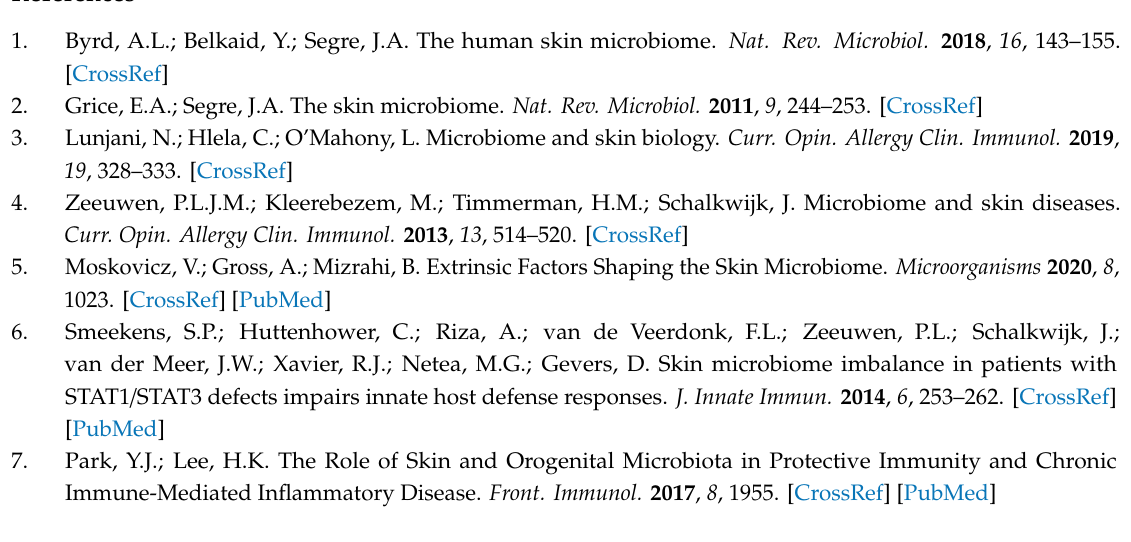
Table S1: DADA2 denoising statistics of 16S rRNA gene sequences. Table S2: Major MetaCyc pathways (0.5% at least one of age groups) by age groups in forehead skin. Table S3: Major MetaCyc pathways (0.5% at least one of age groups) by age groups in hand